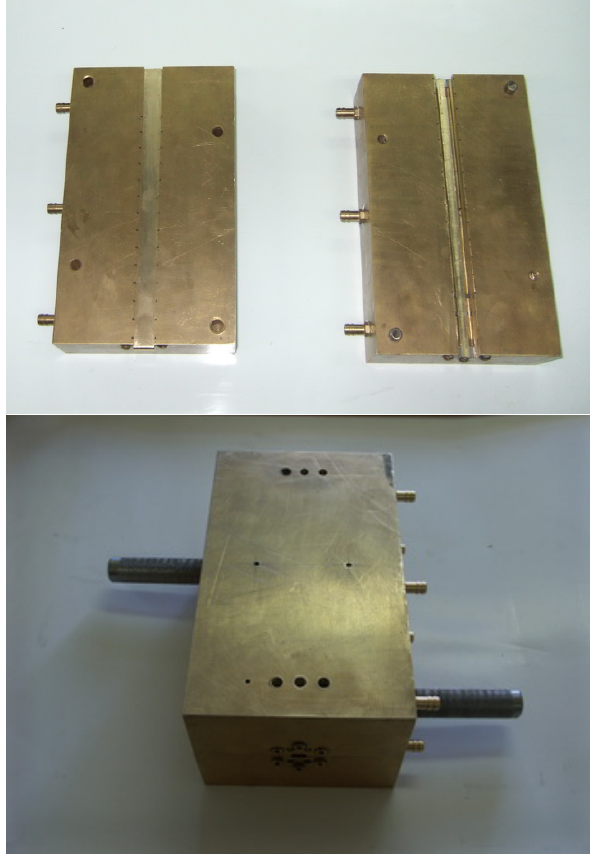
Figure 7: Pressure calibrator; view of upper and bottom part and an assembled calibrator.